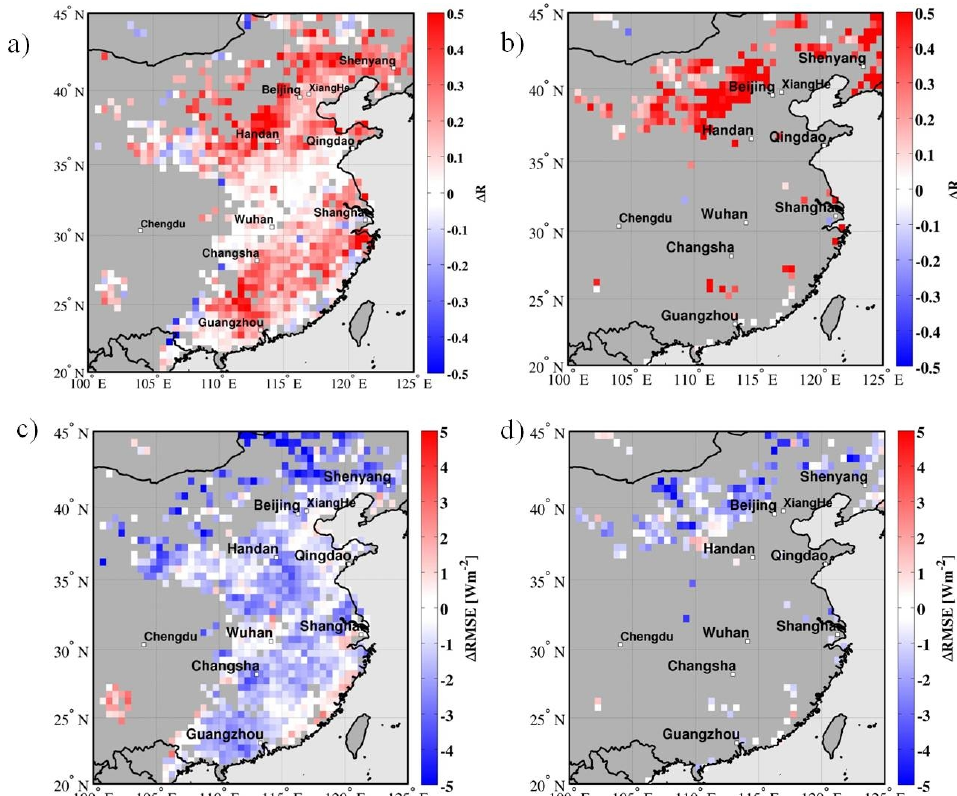
Figure 6. An example of the correlation coefficient (between AOD and CERES TOA fluxes) and RMSE anomalies defined as the difference with and without the normalization procedure. The anomalies are shown for October 2009 separately for grid cells with initially (i.e., without the normalization) positive (a, c) and negative (b, d) correlations.